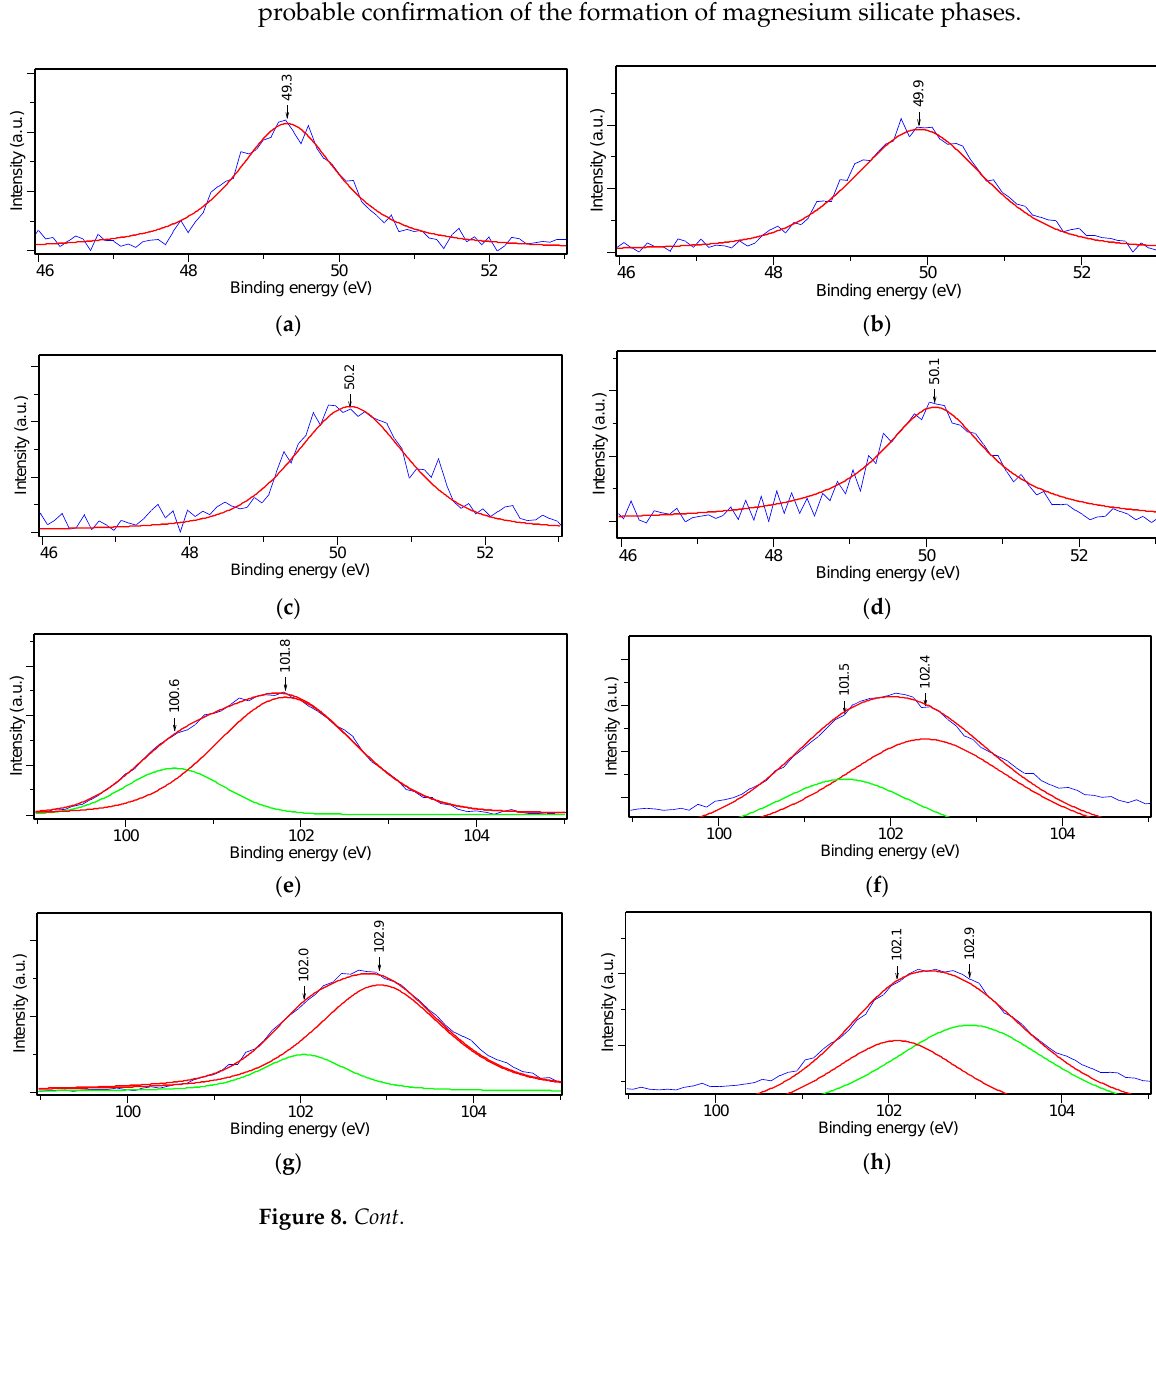
spectrum consists of Fe 2p 3/2 and 2p 1/2 doublet peaks interspaced by 13.6 eV. The Fe 2p 3/2 bands of the S1FeSUB and S1FeXS samples were fitted wit h three peaks at ≈712.0 eV, which is typical of Fe 2+ , at ≈715.0 eV , and finally at ≈725. 5 – 725.7 eV (Figure 8m,n) [44 – 46].